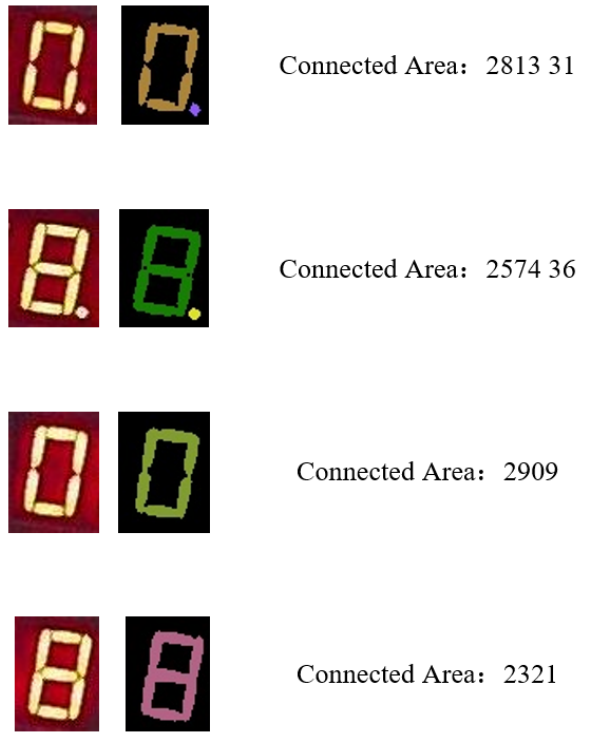
Figure 15. Tail with decimal point and tail without decimal point partial result